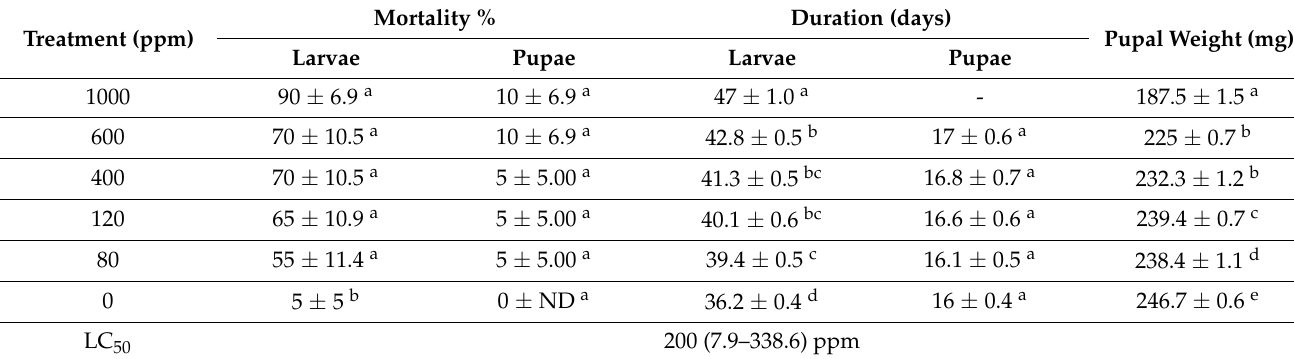
Table 4. Insecticide and insectistatic activities from nonanal against Spodoptera frugiperda